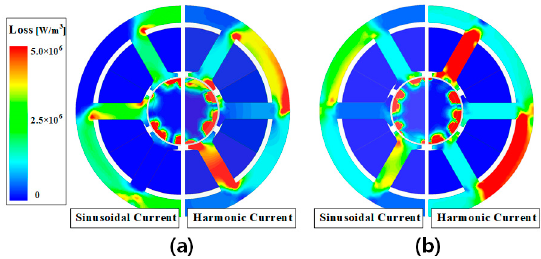
Figure 8. Electromagnetic loss distribution according to current waveform of ( a ) the concentrated and ( b ) distributed winding models.